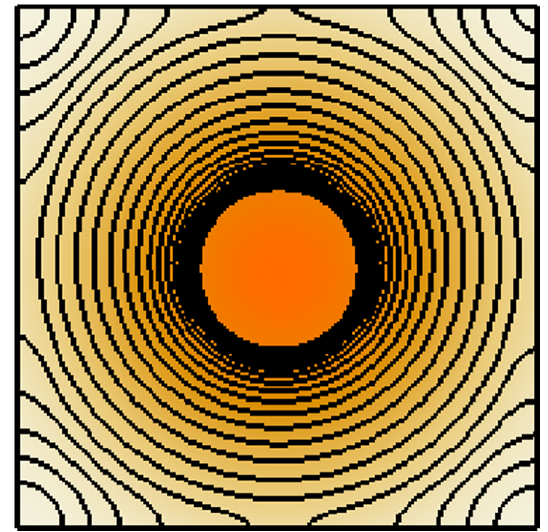
FIG. 12. Evolution of a circular isogloss (initial radius 30) in a 200 × 200 system with unit background population density, together with a central city contributing additional density ρ ð r Þ ¼ ð ρ − 1 Þ exp f − r 2 = ð 2 R 2 Þg , where r is distance from city 1 center, R ¼ 40 , and ρ 1 ¼ 21 . Parameter values σ ¼ 4 , β ¼ 2 . Evolution times t ∈ f 10 ; 20 ; 30 ; … ; 300 g